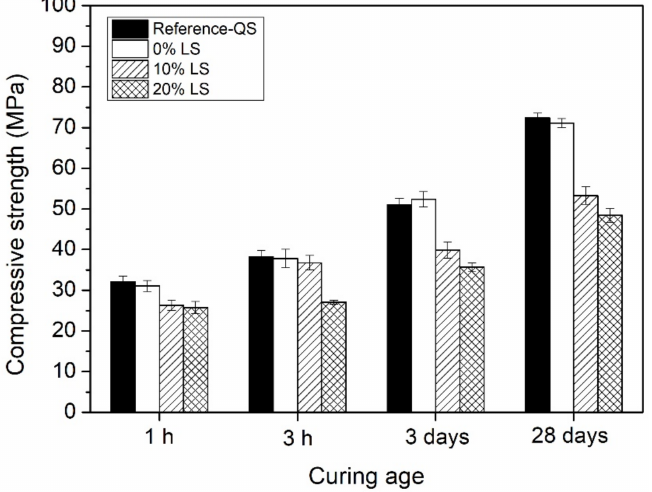
Figure 4. Compressive strength at different curing ages of 1 h, 3 h, 3 days, 28 days of MAPC mortar samples with quartz sand (Reference-QS) and limestone fines (LS) at different content of 0%, 10%, 20%. In the meantime, limestone fines were found to have negative influence on the in- terfacial bonding strength of MAPC mortar with ordinary concrete matrix. In Figure 5, the interfacial bonding strength of reference sample reached 2.99 MPa and 4.28 MPa at 3 days and 28 days respectively. As the content of limestone fines increased from 0% to 10%, the interfacial bonding strength of MAPC mortar dramatically decreased by more than 60% at both early and later age. With content of 20% limestone fines, the interfacial bonding strength of MAPC mortar dropped to 0.92 MPa and 1.25 MPa at 3 days and 28 days respectively. After loading, a large number of pores were observed on the broken interface of half MAPC matrix. Because of the blistering caused by limestone fines, air bubbles were prone to agglomerate at the bonding interface which reduced the effective bonding area between MAPC mortar and ordinary concrete matrix. Moreover, the mechanical strength of MAPC mortar itself decreased with increasing limestone fines as aforementioned. As a result, the interfacial bonding strength was significantly reduced.